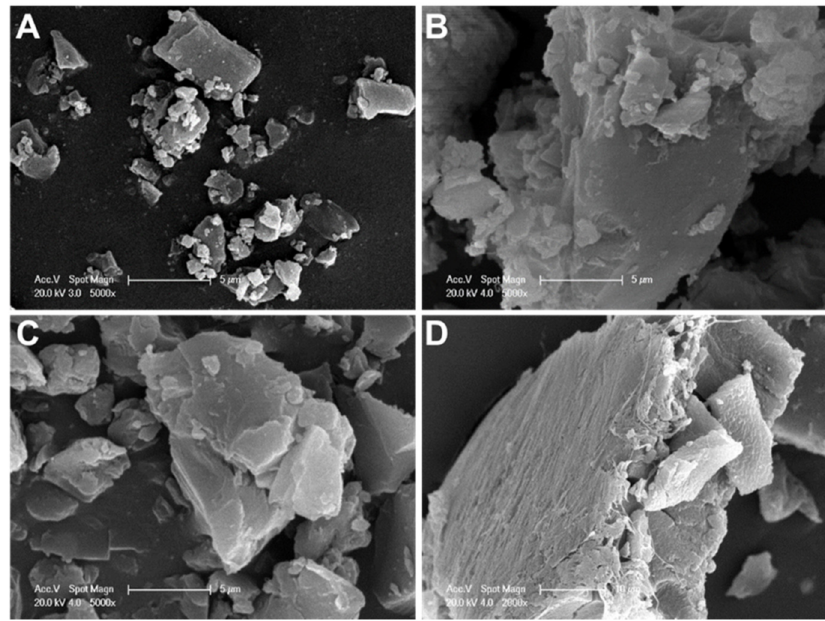
Figure 2. SEM images of different doxorubicin salts: ( A ) sulfate salt at pH 4, ( B ) sulfate salt at pH 7,